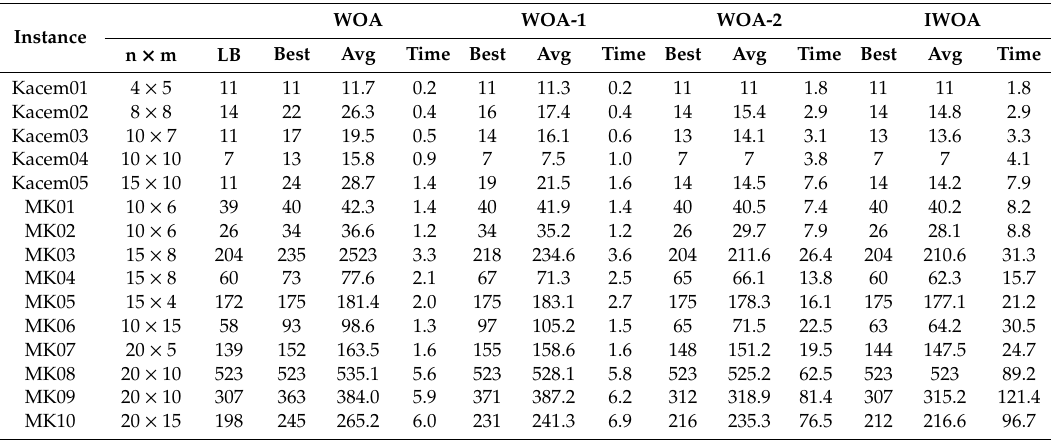
Table 1. E ff ectiveness analysis of improvement strategy. See Section 5.2 for column descriptions. WOA—whale optimization